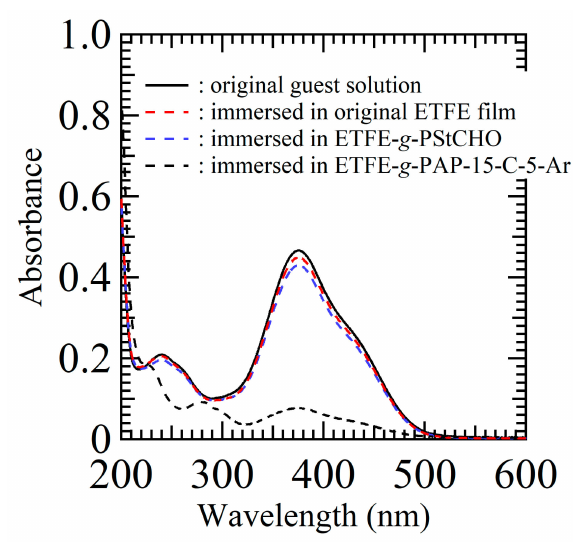
Figure 8. UV–Vis spectra of the aqueous azo-NH 3 Cl solution (original concentration of 5 µ g · ml − 1 ) before and after immersed in original ETFE film, ETFE- g -PSt-CHO, and ETFE- g